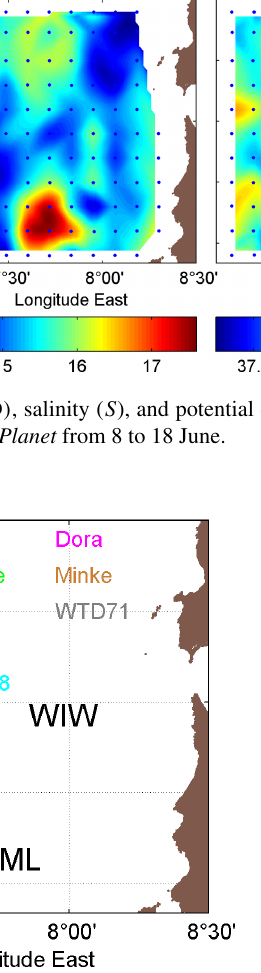
Figure 8. Positions (symbols) and June dates (numbers) of all CTD and glider profiles with WIW and TML observations, respectively ( T < 13.3 ◦ C and S < 38.33 between 100 and